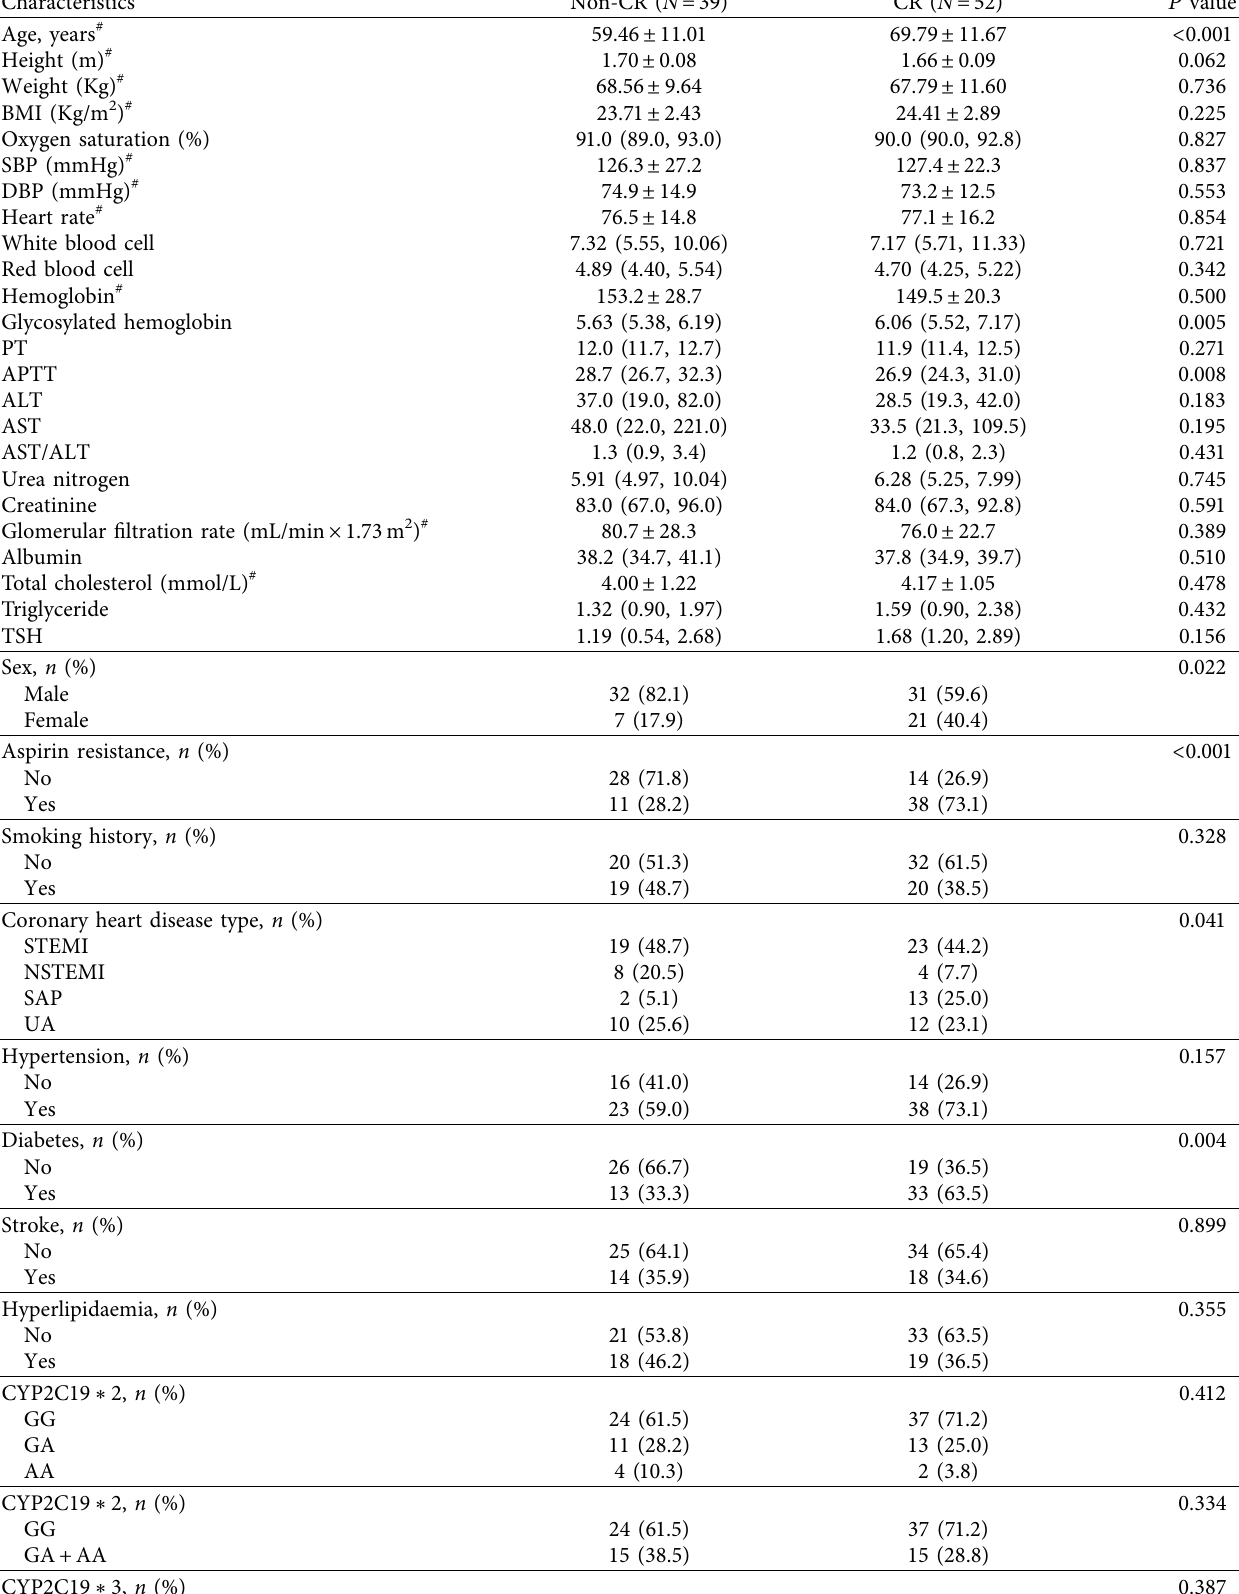
Table 2: Comparison of differences in baseline information between CR and non-CR for all participants.